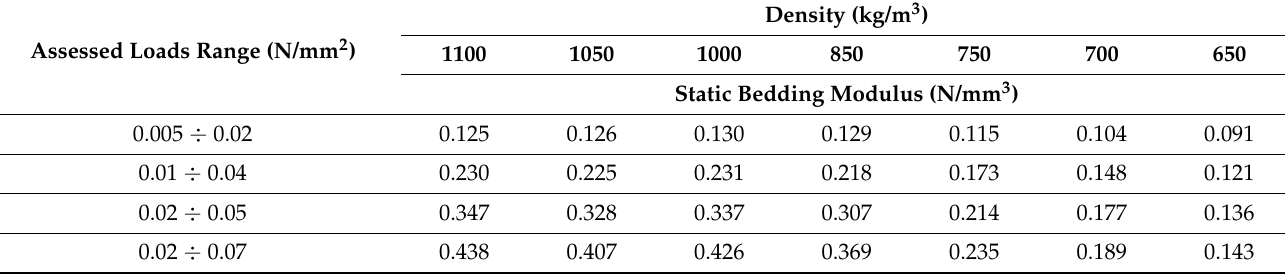
Figure 3. Diagrams of static characteristics of the elastic cover of prototype rail dampers obtained for seven densities of SBR granulate (650–1100 kg/m 3 ). Table 1. Static bedding moduli of the elastic cover of prototype rail dampers obtained for seven densities of SBR granulate (650–1100 kg/m 3 ).